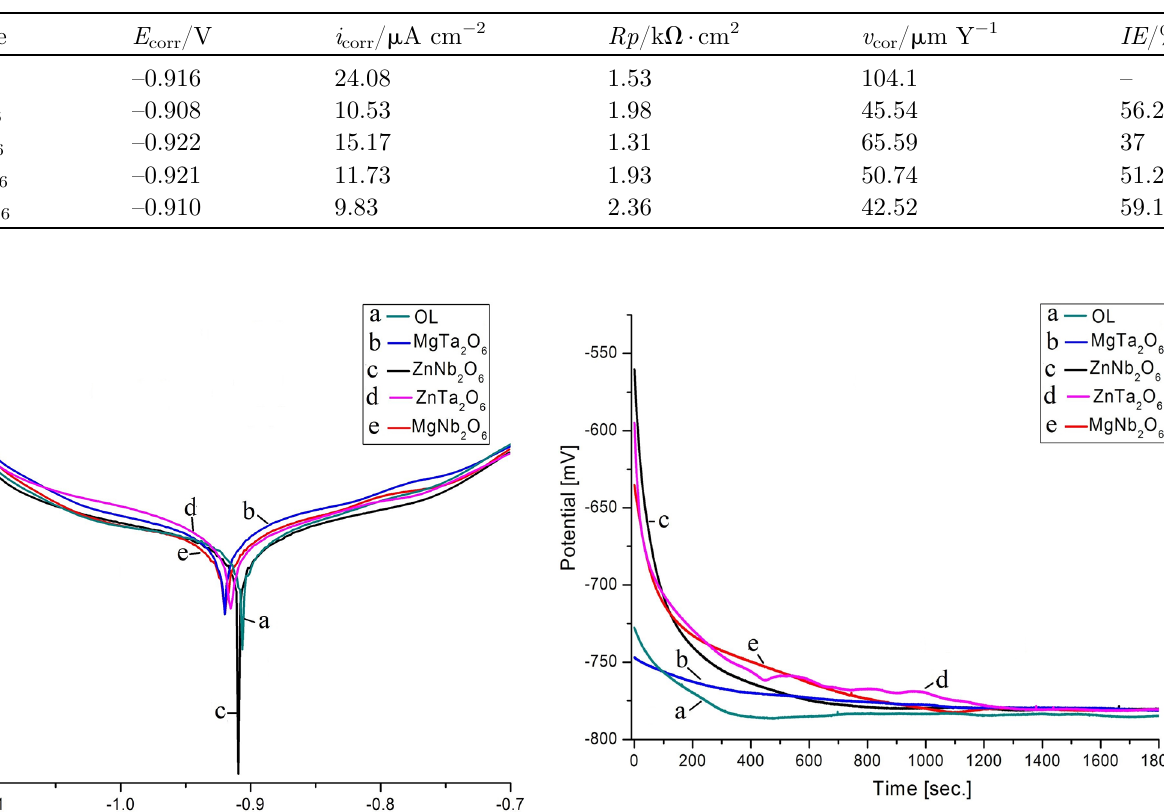
Fig. 7. Evolution of open circuit potential with time for investigated electrodes in 0.5M Na 2 SO 4 electrolyte solution for: (a) OL , (b)MgTa 2 O 6 , (c) ZnNb 2 O 6 , (d) ZnTa 2 O 6 and (e) MgNb 2 O 6